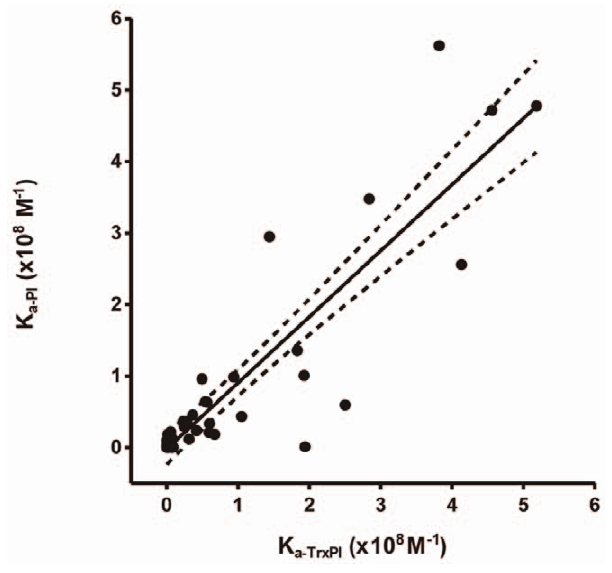
Figure 5. Correlation between K a obtained using TrxPI or PI in SPR assays. K a results were achieved by SPR using either TrxPI or PI as the immobilized antigen on sensor chip. The regression slope was 0.86 6 0.07 and the correlation coefficient (r 2 ) was 0.80. doi:10.1371/journal.pone.0033574.g005 PLoS ONE |